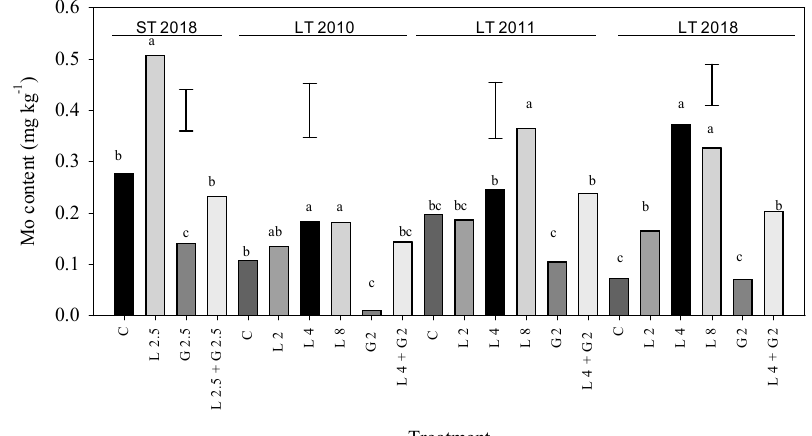
Figure 1. Mo concentration (mg kg − 1 ) response for the treatments control (C), 2.5 t L ha − 1 (L2.5), 2.5 t G ha − 1 (G2.5), 2.5 t L ha − 1 plus 2.5 t G ha − 1 (L2.5 + G2.5) measured at the ST experiment in 2018 and for the treatments control (C), 2.0 t L ha − 1 (L2), 4.0 t L ha − 1 (L4), 8.0 t L ha − 1 (L8), 2.0 t G ha − 1 (G2), 4.0 t L ha − 1 plus 2.0 t G ha − 1 (L4 + G2) at the LT experiment in 2010, 2011 and 2018. For each year,